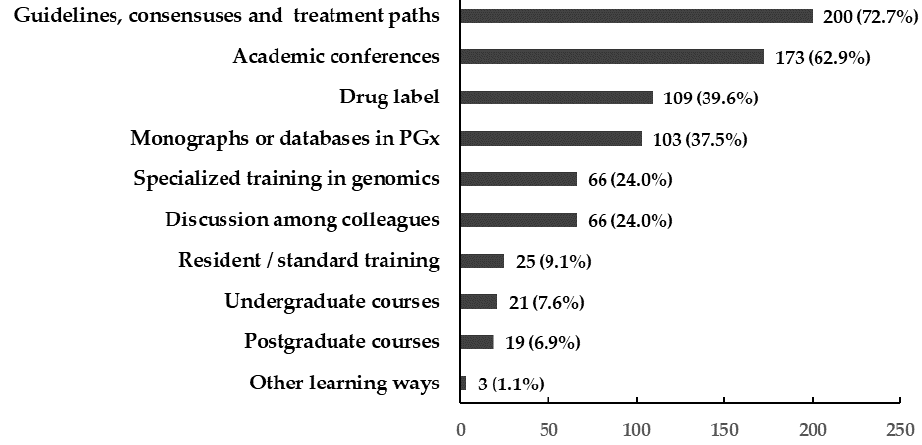
Figure 1. Physicians’ knowledge of resources related to PGx testing.